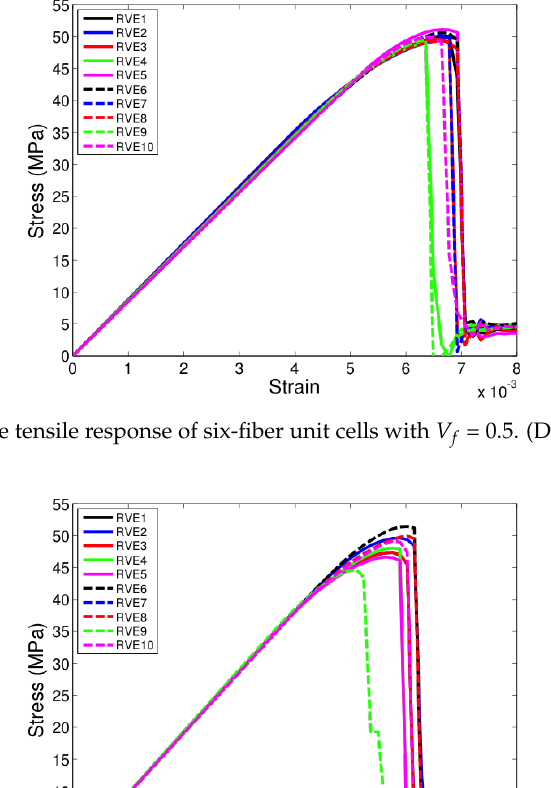
f = 0.6. (D’Mello and Waas [12]).